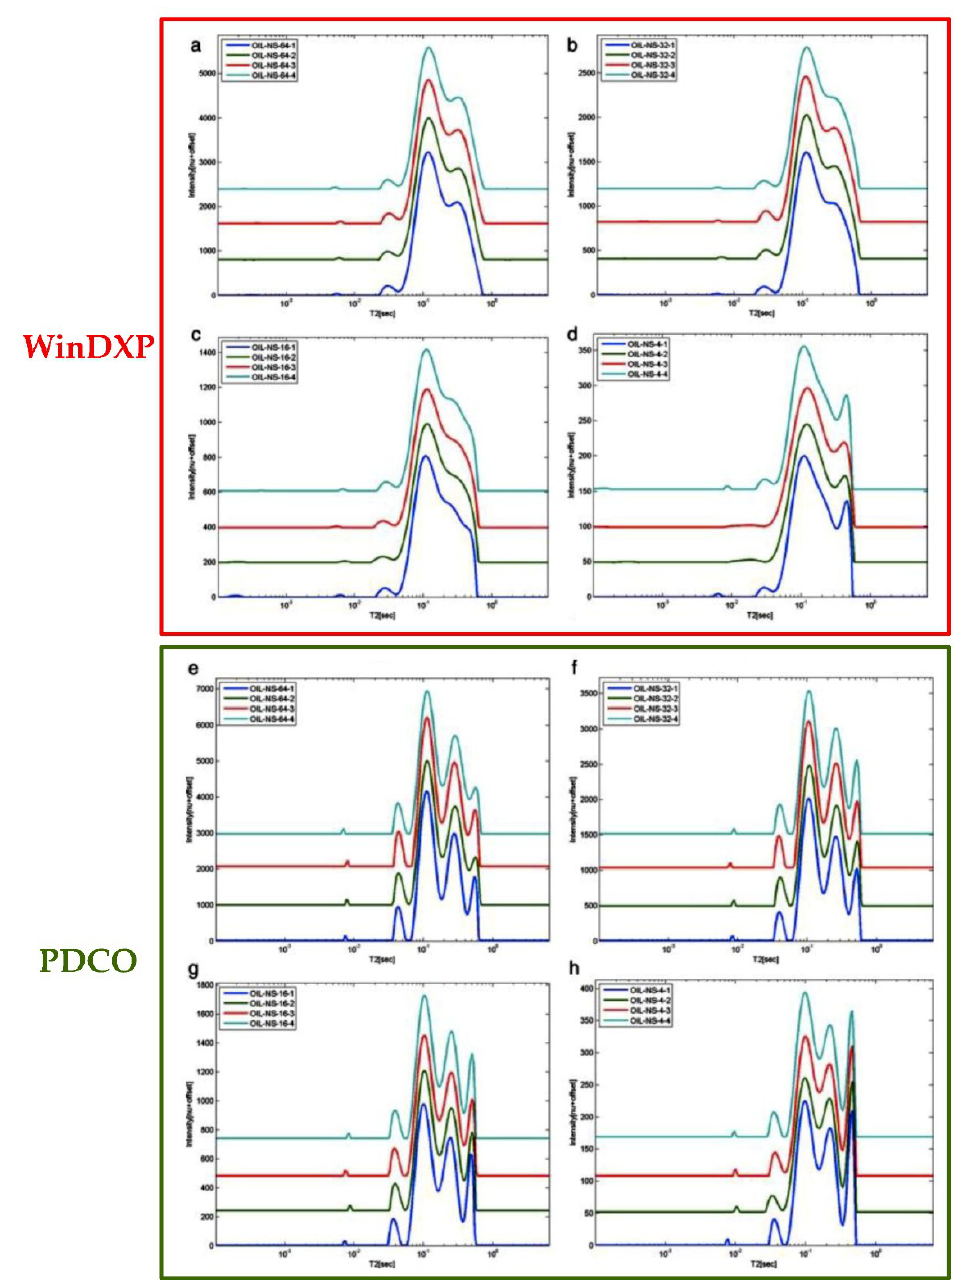
Figure 2. Comparison of 1D WinDXP T 2 spectra ( a – d ) (RED) vs. PDCO T 2 ( e – h ) (GREEN) data processing of rapeseed oil. Reprinted with permission from ref. [21]. Copyright 2013